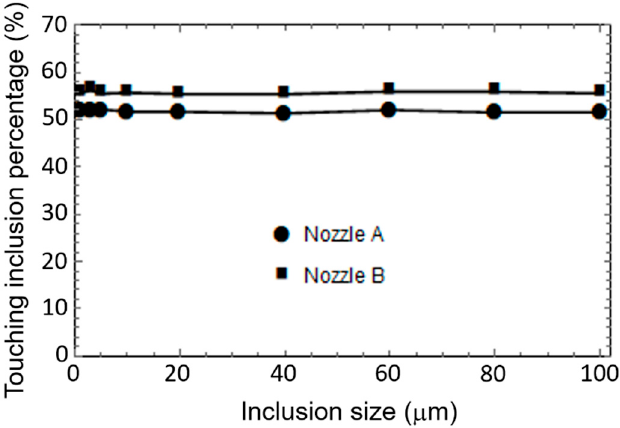
Figure 3. Touching inclusion percentage at the nozzle wall for nozzle A and Nozzle B.